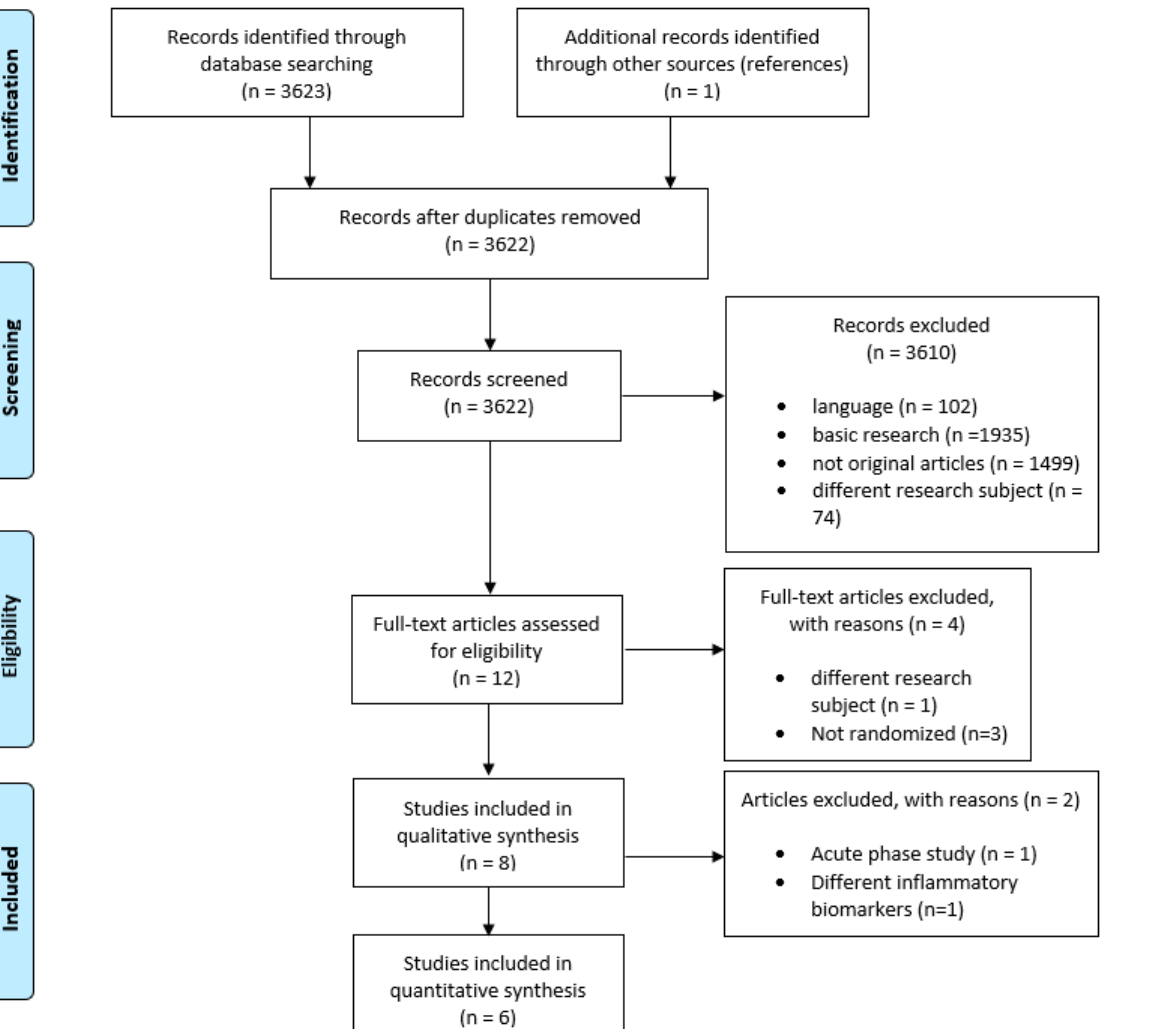
Figure 1. Identification and selection of the eligible studies according to the PRISMA criteria.